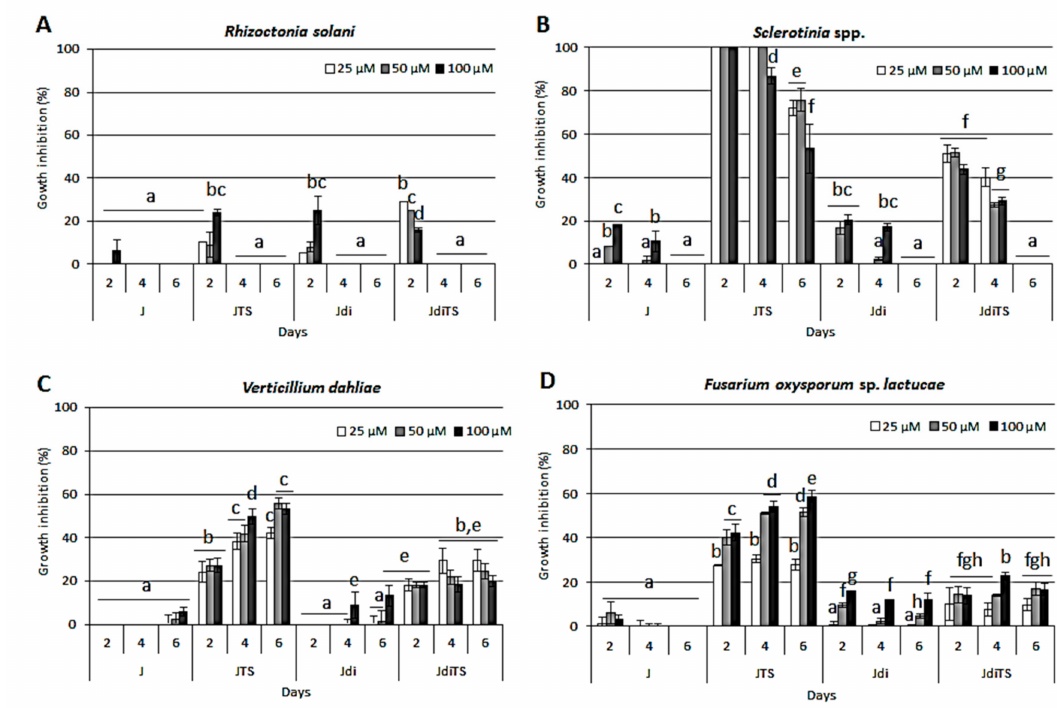
Figure 5. E ff ect of compounds on the growth of horticultural crop pathogens ( A ) R. solani , ( B ) Sclerotinia spp., ( C ) V. dahliae and ( D ) F. oxysporum . Culture medium was amended with increasing concentrations of molecules (from 25 to 100 µ M) on the basis of the species; values are reported as inhibition percentage as compared to the control (DMSO amended cultures) ± S.D. Di ff erent letters indicate statistically significant di ff erences ( p <